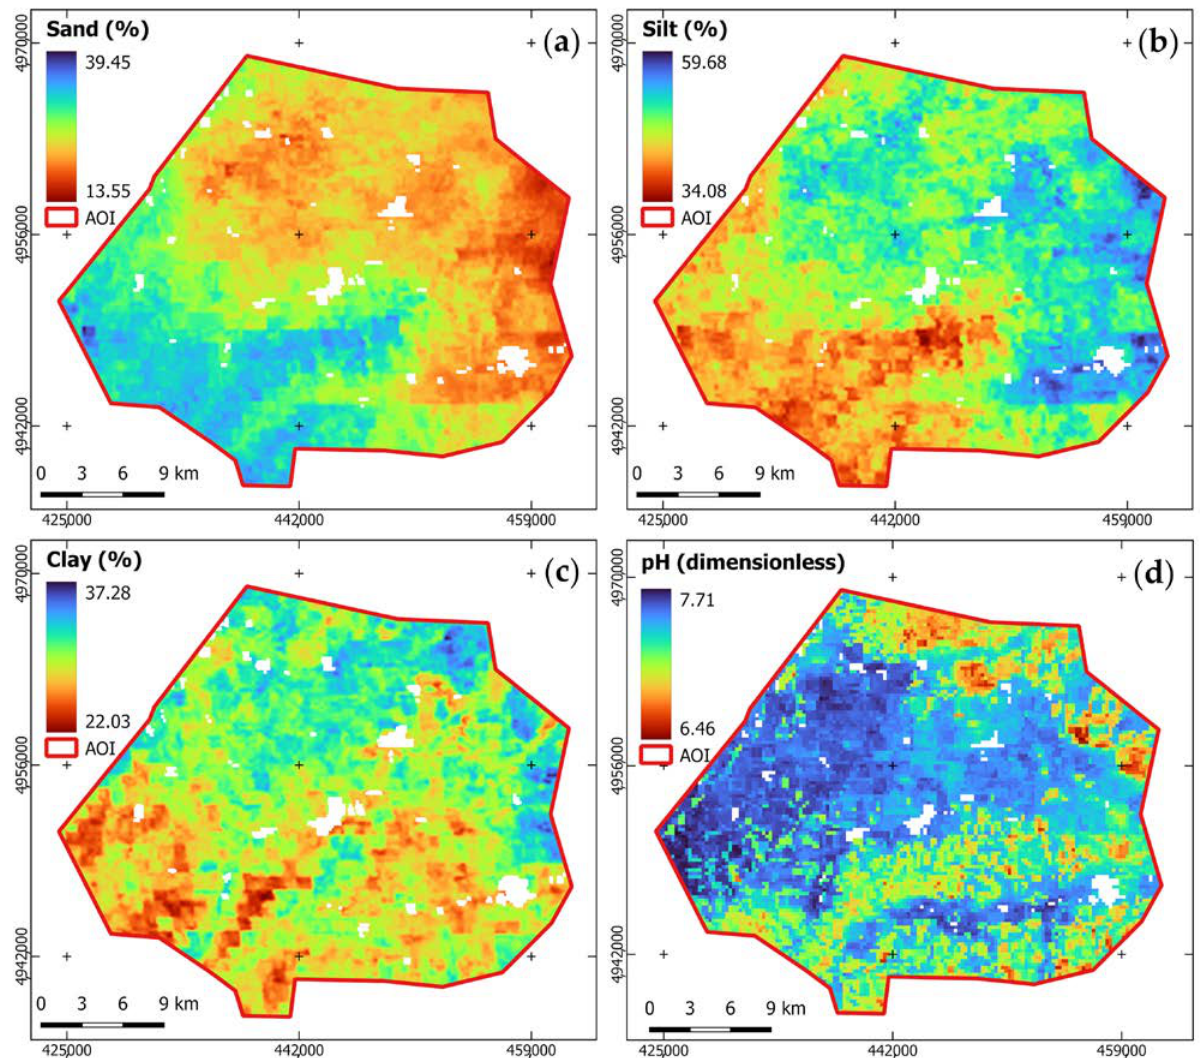
Figure 5. Raster layers mapping soil textural features in the study area: ( a ) sand (SA — %); ( b ) silt (SI — %); ( c ) clay (CL — %); and ( d ) pH (dimensionless) (EPSG: 32,632, WGS 84/UTM zone 32N).